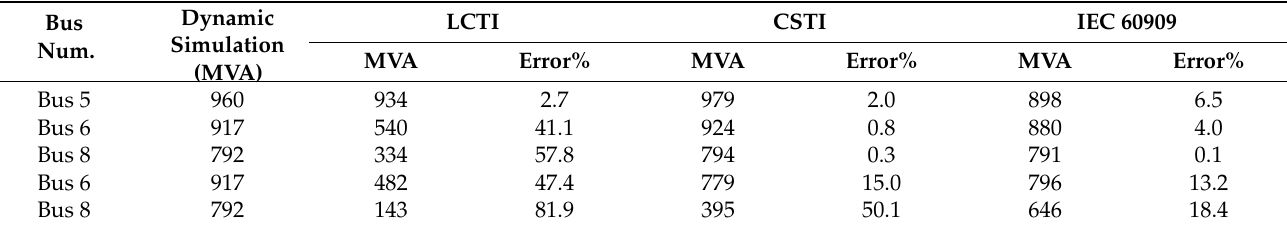
Table 5. Fault level MVA obtained in scenario one.